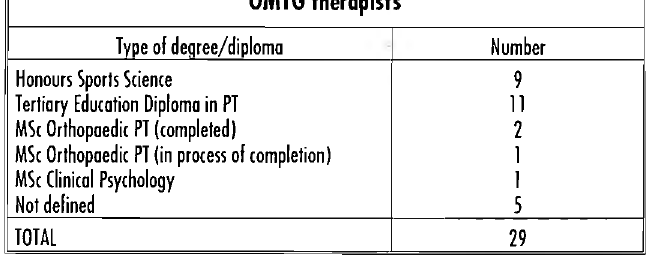
Table II. Type of post-graduate qualifications held by